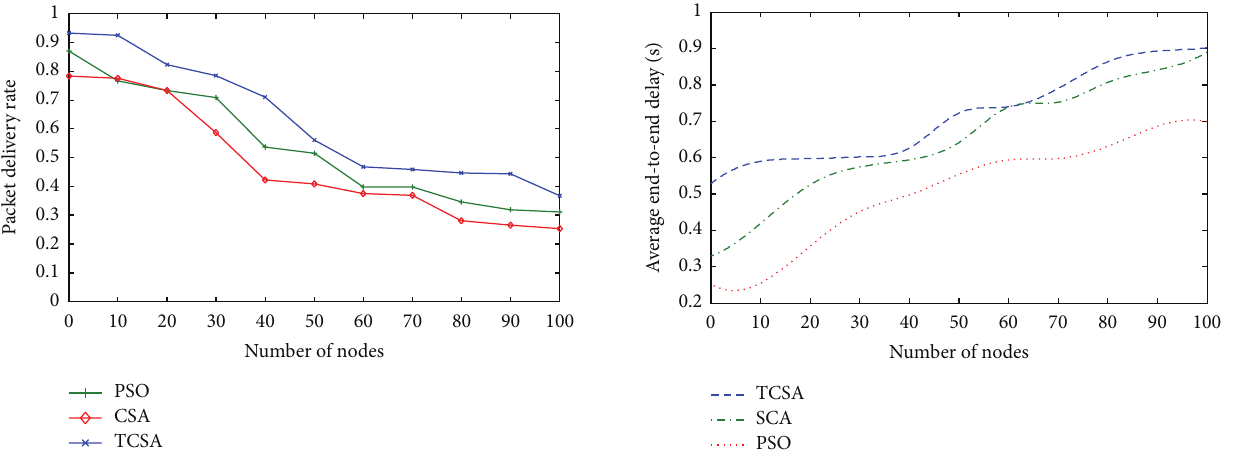
Figure 4: Plot between average end-to-end delay and network size.